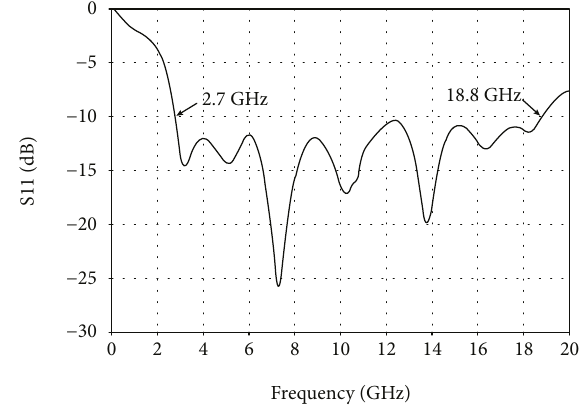
Figure 6: Simulated S11 parameter of the proposed